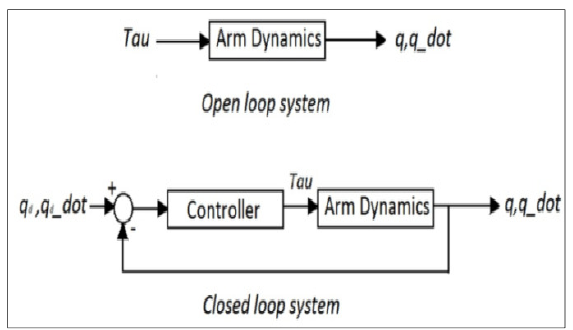
Fig. 5. Control System